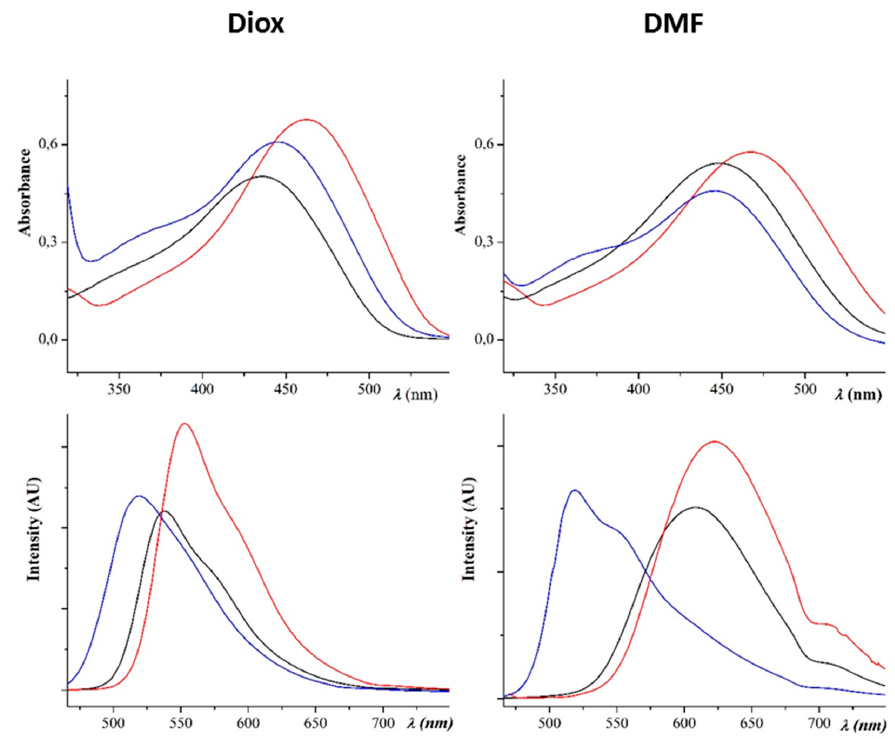
Figure 1. Absorption ( top ) and emission ( bottom ) spectra of CN-PV-NH 2 (black line), CN-PV-NHMe (red line) and CN-PPV (blue line), in dioxane and DMF solution. In solution, the absorption was recorded in the range from 436 to 470 nm and the emission from 518 to 622 nm with a red-shift effect depending on solvent polarity. In dioxane, the compounds appear as yellow-green emitters. In more polar solvents, such as DMF, we observed a red shift of the emission peak. This is consistent with the existence of a polar excited state, which is stabilized in a